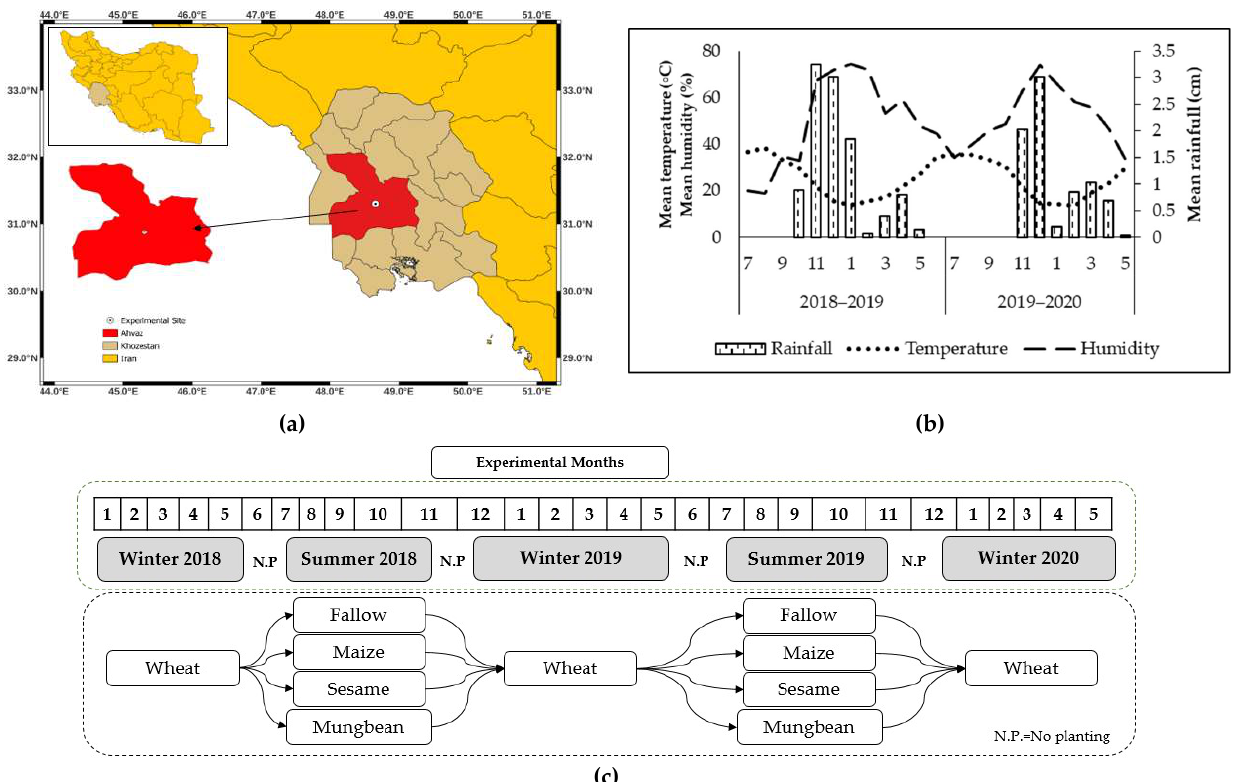
Figure 1. ( a ) Location of Khuzestan province and the experimental site in Iran, ( b ) average monthly rainfall, average temperature, and humidity in the experiment site during the period of 2018–2020, and ( c ) schematic diagram of the cultivation calendar for winter and summer crop rotation systems during the study period. N.P. = no planting.